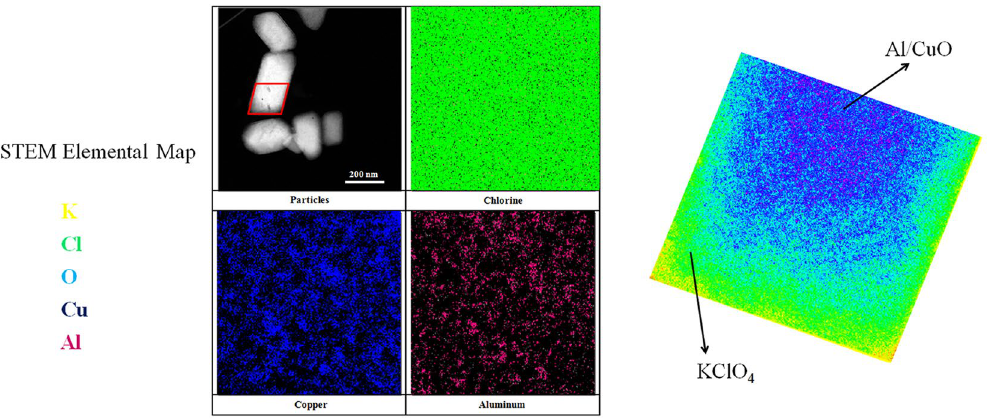
Figure 6. STEM elemental map showing the distribution of Cl, Cu, and Al in the